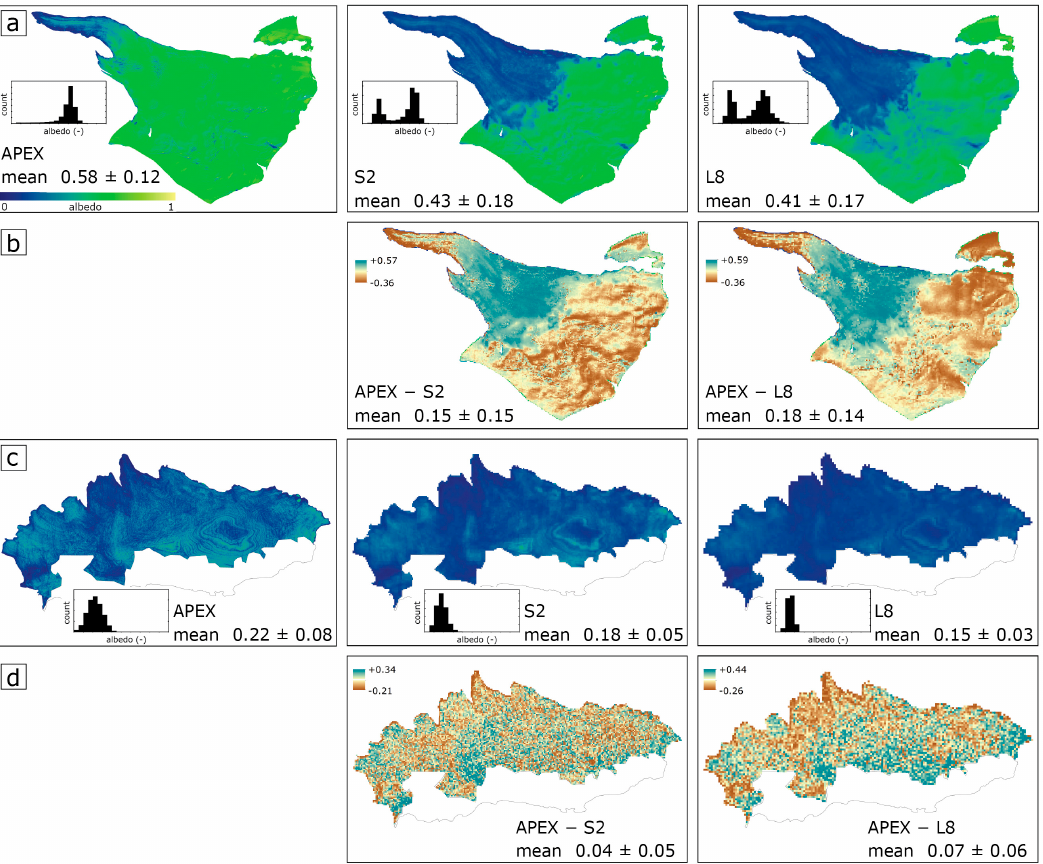
Figure 7. Albedo product derived using the SBA ani algorithm and three different datasets: APEX ( left ), Sentinel-2 ( centre ) and Landsat 8 ( right ) and difference maps of the albedo products: APEX minus Sentinel-2 ( centre ) and APEX minus Landsat 8 ( right ) for Findelengletscher ( a,b ) and Glacier de la Plaine Morte ( c,d ). The insets in ( a ) and ( c ) show the albedo frequency distribution per glacier and product.